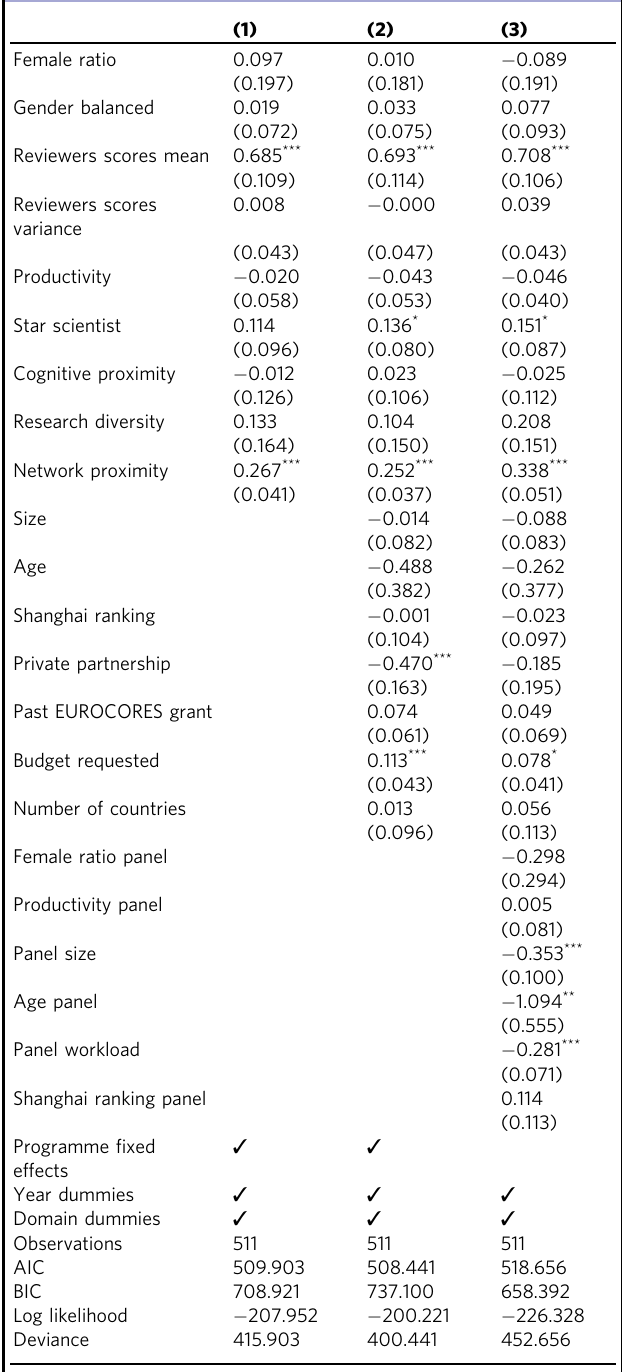
Table 5 Coef fi cient estimates — second expert panel